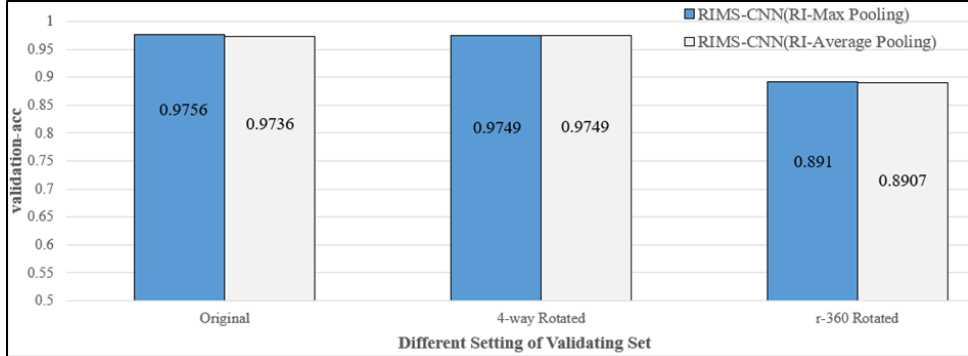
Figure 20. Comparing RI-max pooling with RI-average pooling in the different MNIST settings.